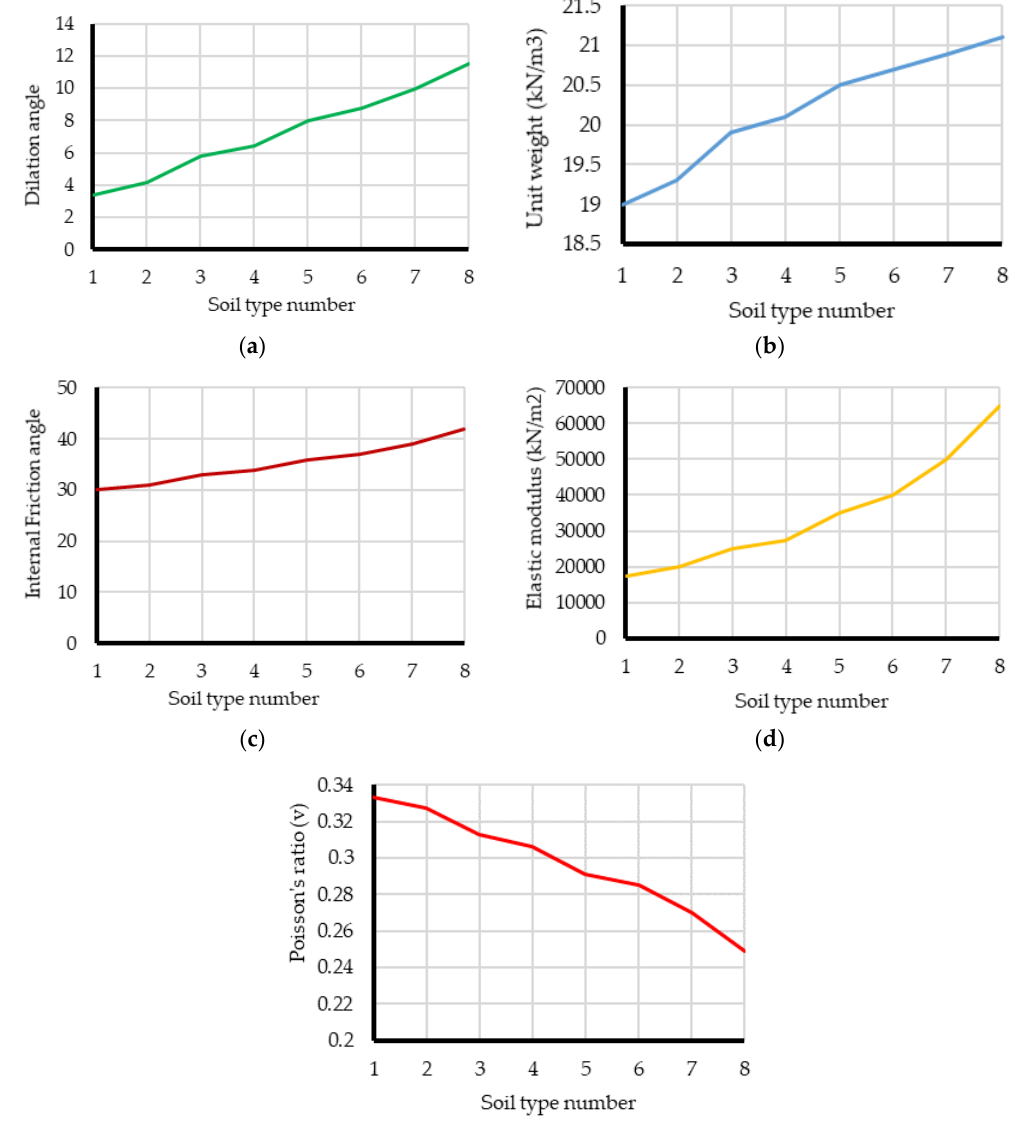
Figure 6. A summary of the range of input information vs. soil type, ( a ) Dilation angle, ( b ) Unit weight, ( c ), Internal friction angle, ( d ) Elastic modulus, ( e ) Poisson’s